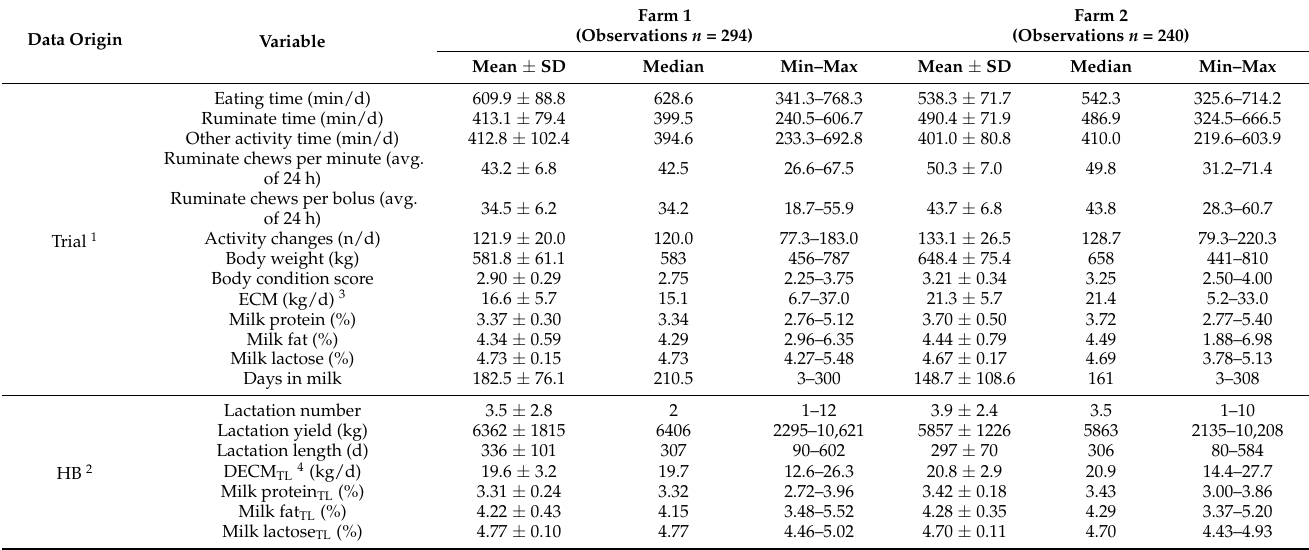
Table 2. Descriptive summary of chewing sensor variables and cow characteristics by